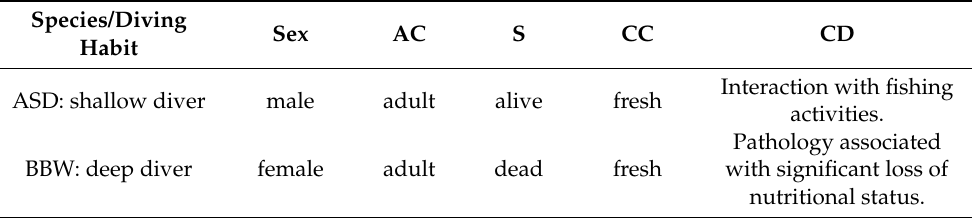
Table 1. Data of the two analyzed animals. AC, age category; S, stranding; CC, condition code; CD, cause of death. CD determined according to pathologic categories in